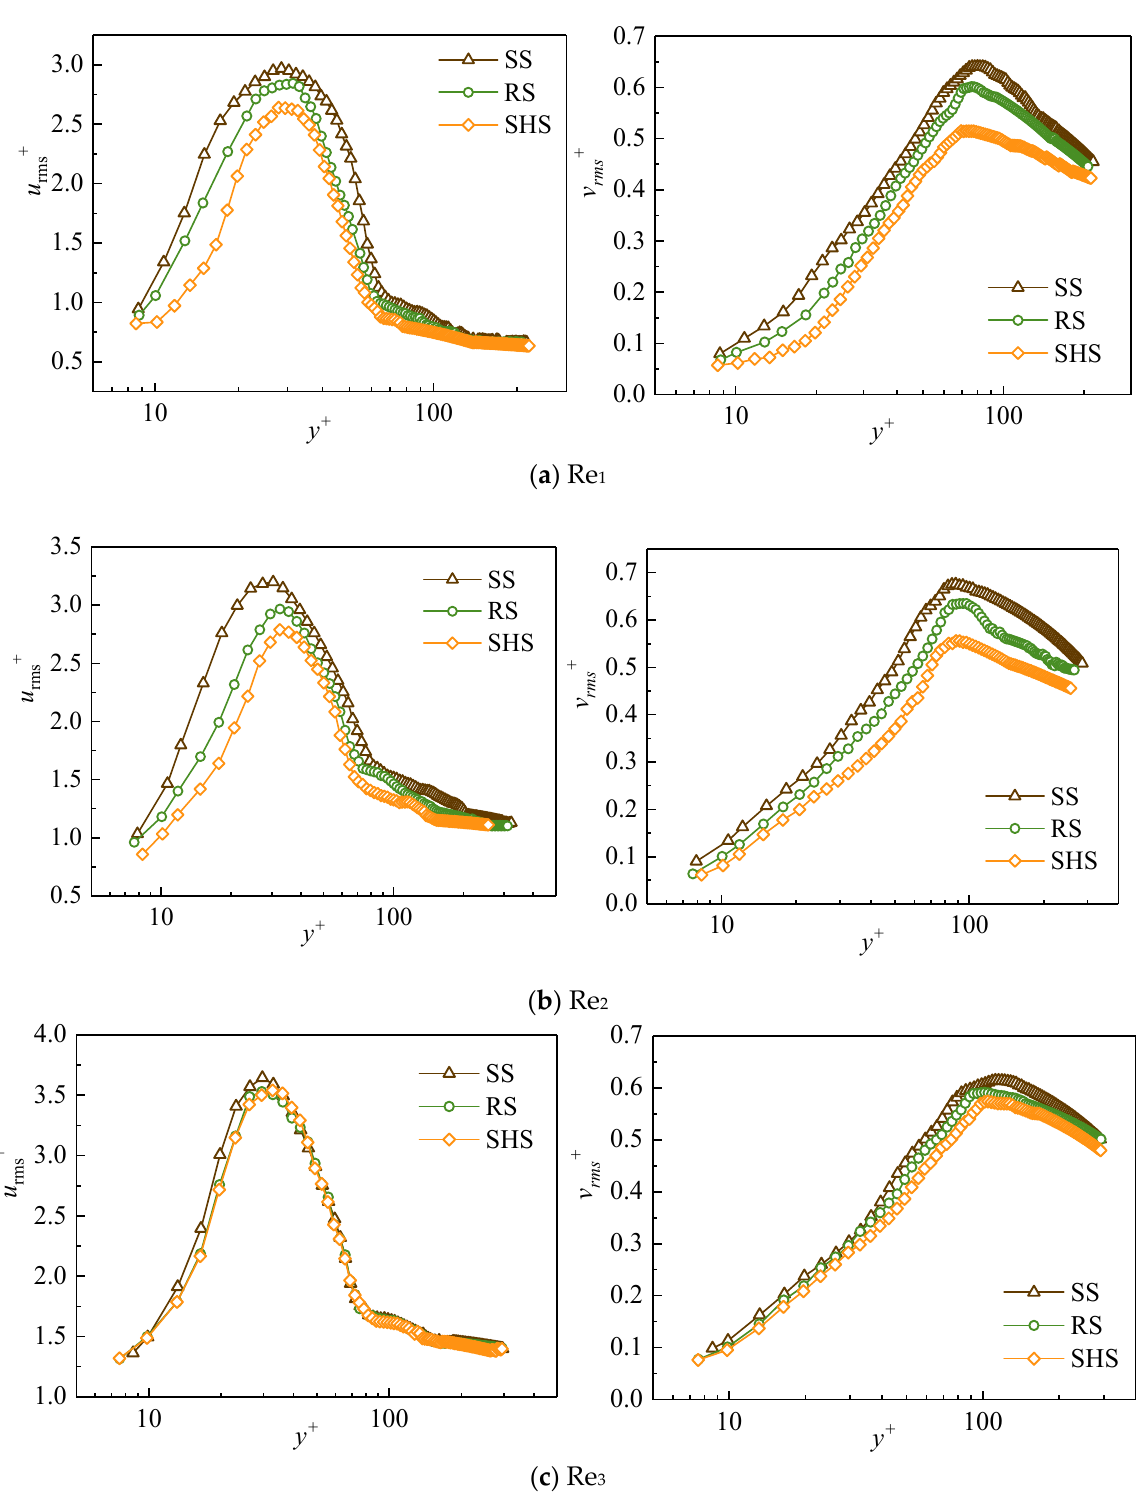
Figure 5. Streamwise and normal turbulence intensity at different Reynolds numbers.